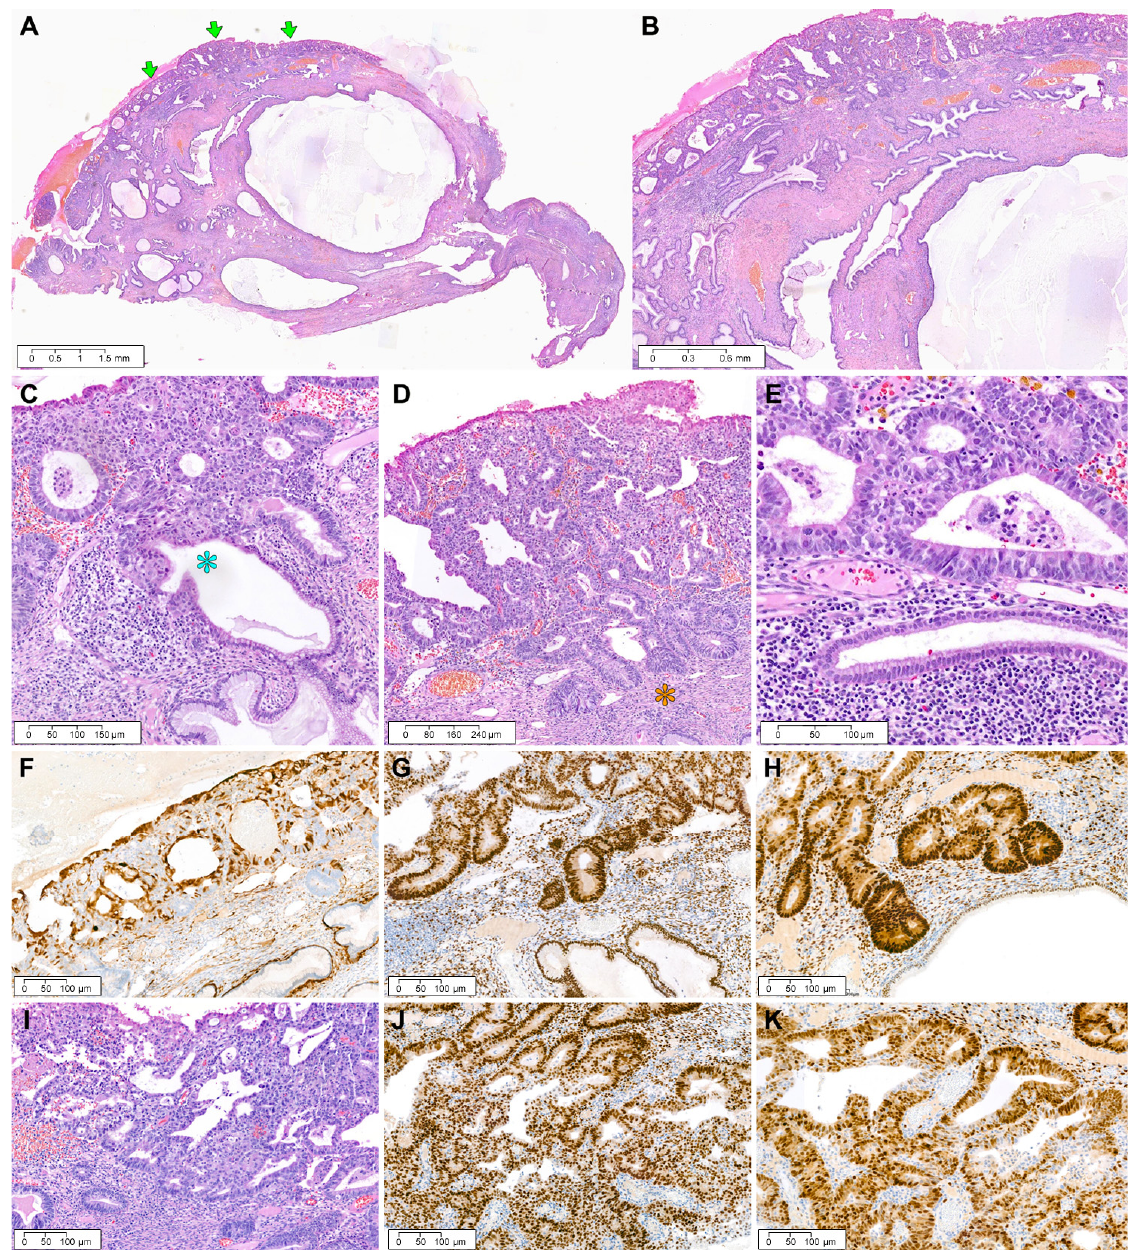
Figure 5. Grade 1 endometrial EC involving ECP: case 4. ( A ) The polypectomy specimen demon- strates the tumor tissue (green arrows) involving the surface. ( B ) Complex and crowded glandular architecture spreads along the surface and superficial stroma of ECP. ( C ) The EC cells partially involve one endocervical gland (blue asterisk). ( D ) Back-to-back arrangement (orange asterisk) and a lack of the intervening stroma are compatible with grade 1 EC. ( E ) High-power magnification reveals that the tumor glands (upper half) display nuclear stratification, enlargement, hyperchromasia, and loss of nuclear polarity. There is also a non-atypical endocervical gland (lower half). ( F – H ) Immunohisto- chemical staining reveals ( F ) patchy p16 positivity and diffuse and strong expression for ( G ) estrogen and ( H ) progesterone receptors. ( I – K ) Primary endometrial EC exhibits identical ( I ) histological features and immunoreactivities for ( J ) estrogen and ( K ) progesterone receptors to EC involving ECP. ( A – E ) and ( I ), Hematoxylin and eosin staining; ( F – H ), ( J ), and ( K ), immunohistochemical staining using polymer method. Original magnification: ( A ), 15 × ; ( B ), 20 × ; ( C ), 60 × ; ( D ), 40 × ; ( E ), 200 × ; ( F ), 100 × ; ( G ), 100 × ; ( H ), 100 × ; ( I ), 100 × ; ( J ), 100 × ; ( K ), 100 ×